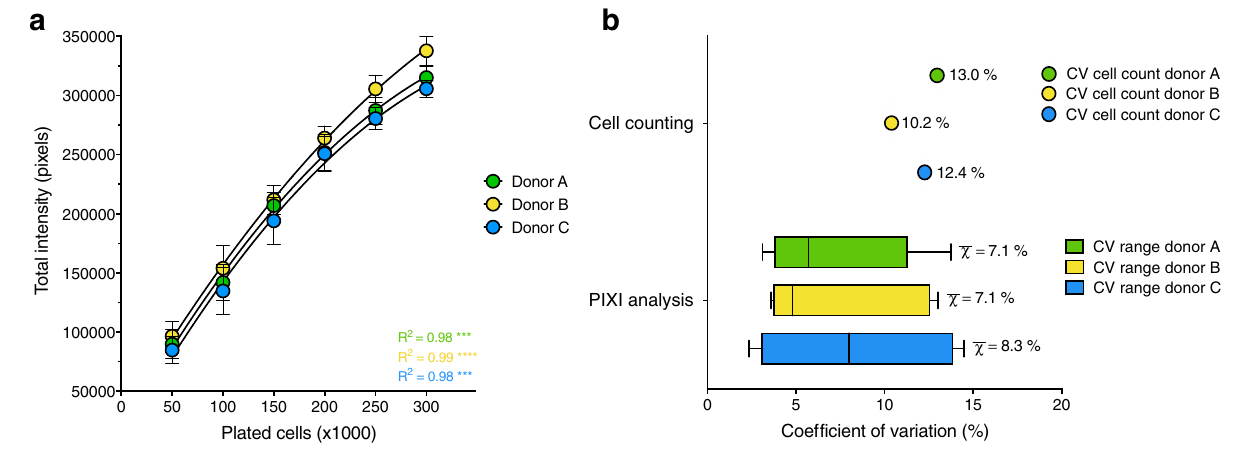
Figure 3. R-integrated pixel intensity (PIXI) analysis from brightfield images as a reproducible image analysis tool. ( a ) Curve fit of the number of plated cells (50–300 × 10 3 cells/well, n = 14–16) versus total brightfield pixel intensity values, indicated by Pearson correlation coefficients (R 2 ). Data is represented as mean ± s.d.. Calibration curves were used to transform total pixel intensity values back into cell numbers using second-order polynomial regression analysis. ( b ) Coefficients of variation (CV in %) within each donor for the cell counts of the total PBMC pool before seeding (n = 8, represented as mean) and the brightfield image PIXI analysis (represented as median ± range; means are visualized by χ